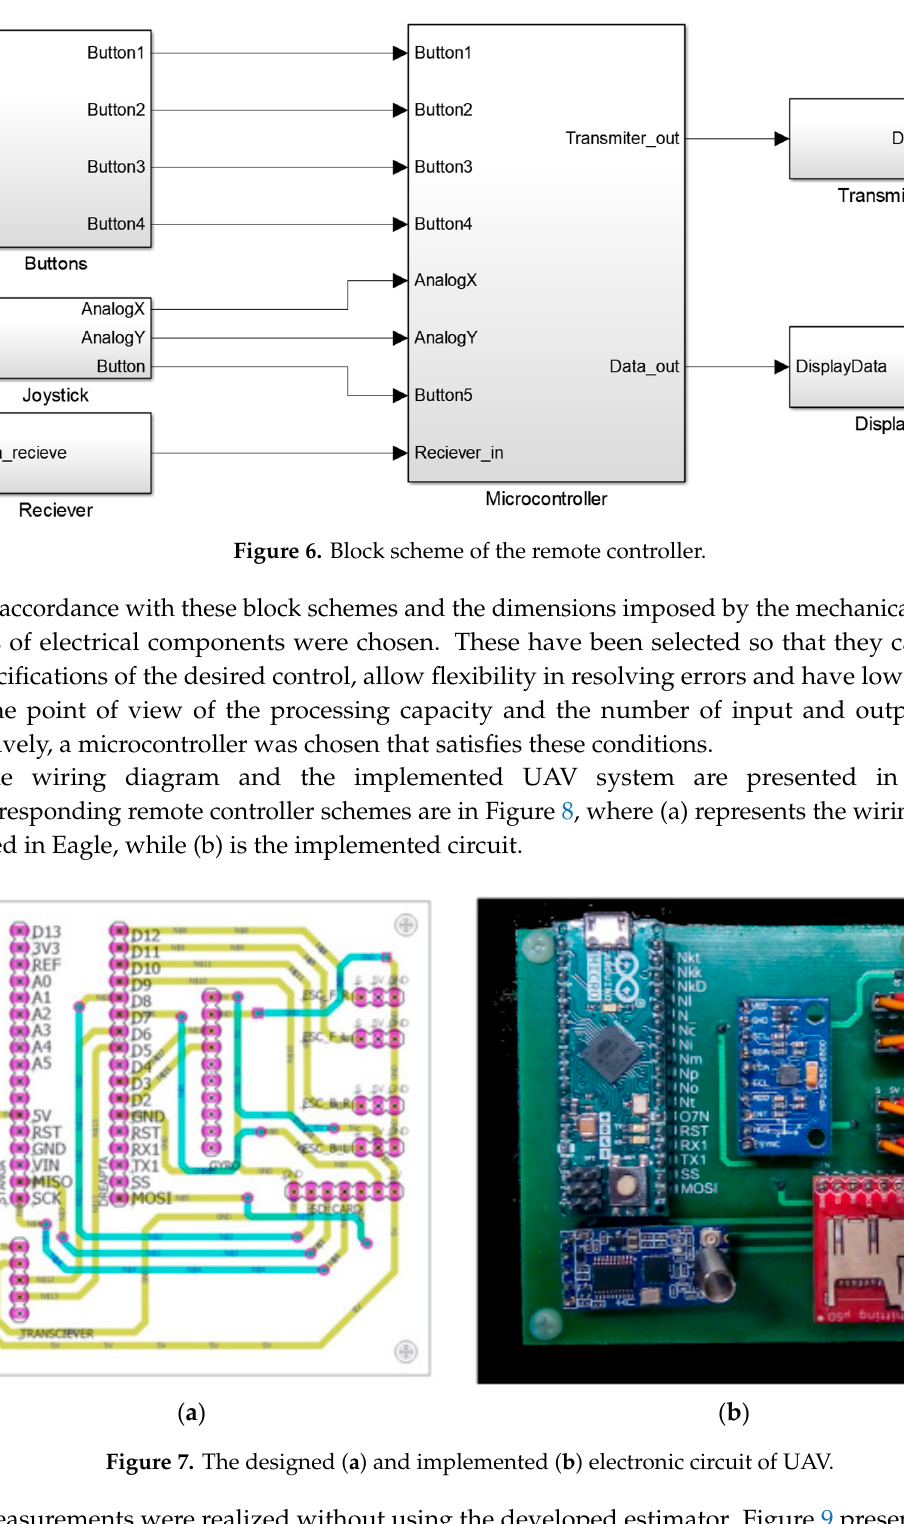
Figure 5. Block scheme of the quadrotor UAV.